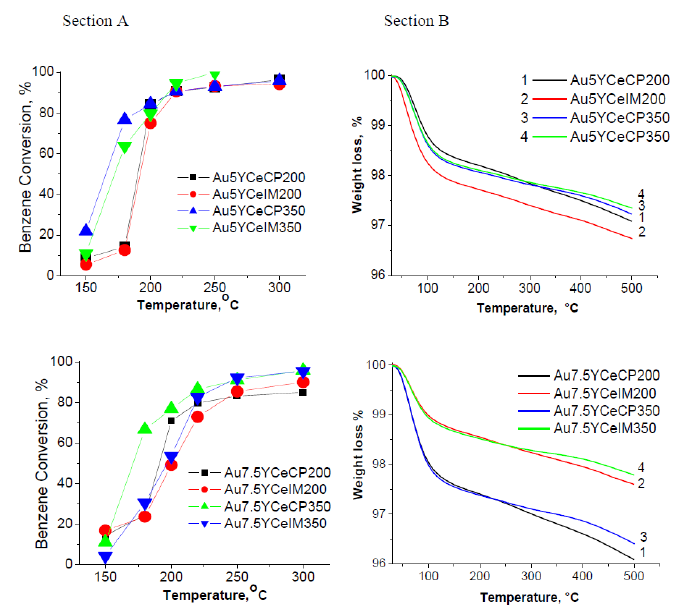
Figure 1. Section A: Comparison of the catalytic activity in complete benzene oxidation (CBO) over gold catalysts on ceria with different Y ‐ doping after pretreatment in air at 200 °C and 350 °C; Section B: TPD results of the corresponding catalysts after oxygen adsorption at 200 °C or 350 °C.